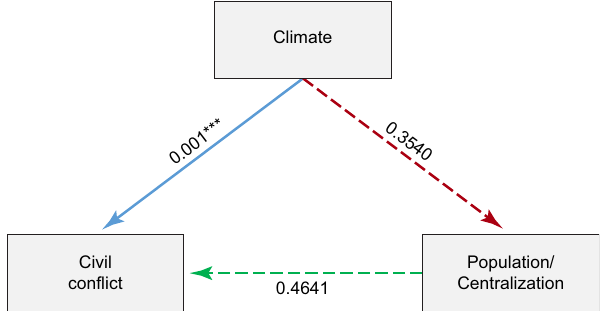
Fig. 3 Summary of model results. The diagram compares the direction and signi fi cance of general linear modeled relationships between climate, population, and civil con fl ict. P -values are given for each relationship, with asterisks denoting signi fi cance. Dotted lines show non-signi fi cant relationships. Colors correspond with model fi t plots in Supplementary Fig.